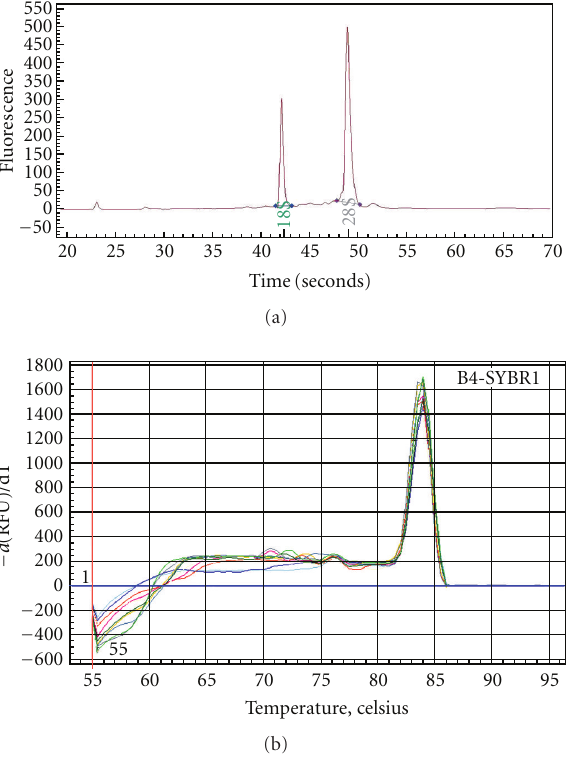
Figure 7: Validation of RNA integrity (a) and assessment of PCR gene product quality (b). Aliquots of extracted RNA from control or PQ-challenged A549 cells with or without pretreat- ment were assessed for RNA concentration and integrity using the Experion automated electrophoresis station. A representative electropherogram displays 18 and 28S rRNA peaks. Representative first-derivative dissociation curves of amplified PCR product of 4h control and PQ-challenged cells pretreated with control media or NAC- or L-NAC-containing media are